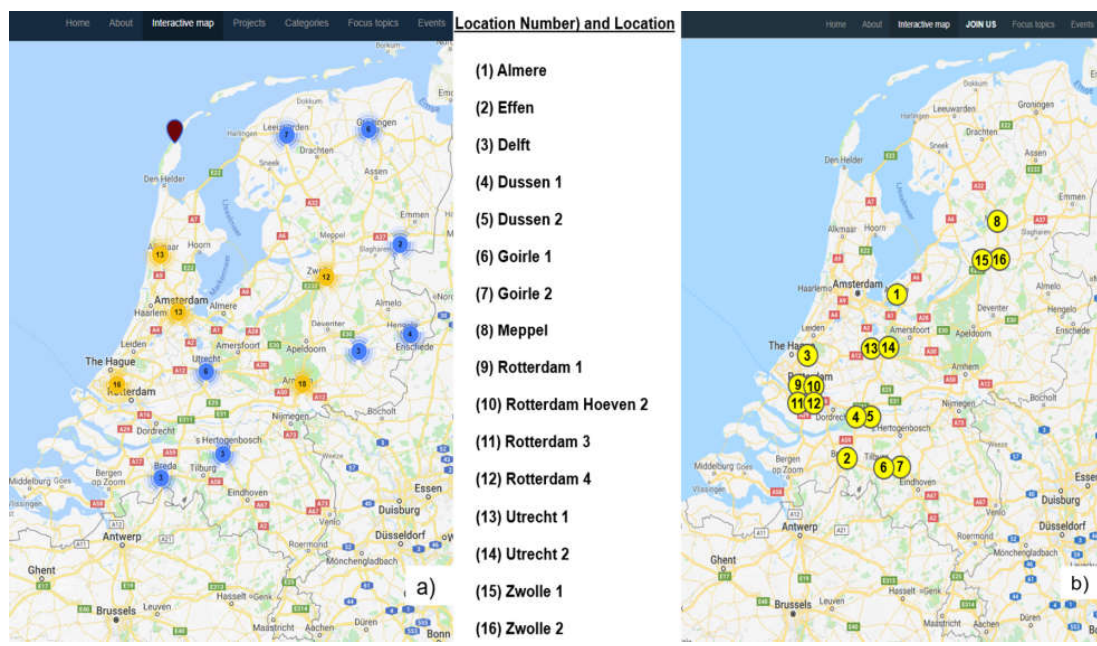
Figure 3. ( a ) 118 locations where permeable pavement have been installed in The Netherlands (Source: https://www.climatescan.nl/map#filter-1-3); ( b ) locations of the 16 study permeable pavements evaluated in the Netherlands .